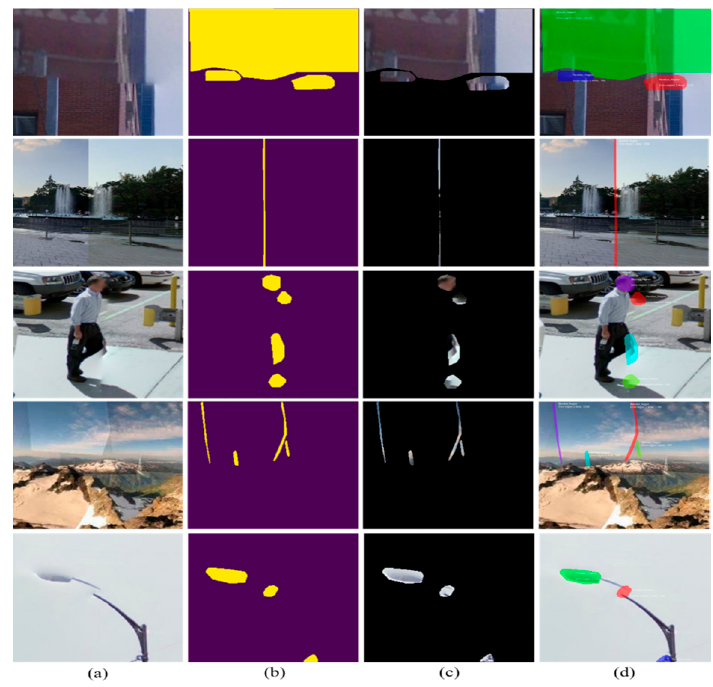
Figure 7. The segmentation results obtained for the distorted stitched patches test set: ( a ) input distorted patch; ( b ) generated mask map; ( c ) distortion-specific patch; and ( d ) final segmented images.